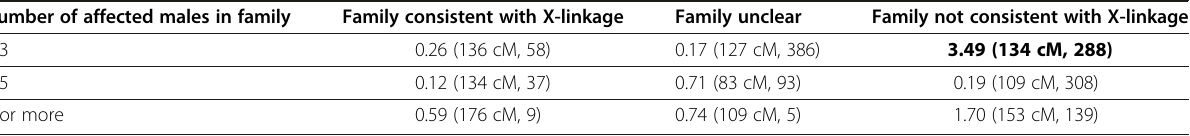
Table 2 Nonparametric, maximum multipoint allele-sharing LODs (location, number of families) for subsets of families Number of affected males in family Family consistent with X-linkage Family unclear Family not consistent with